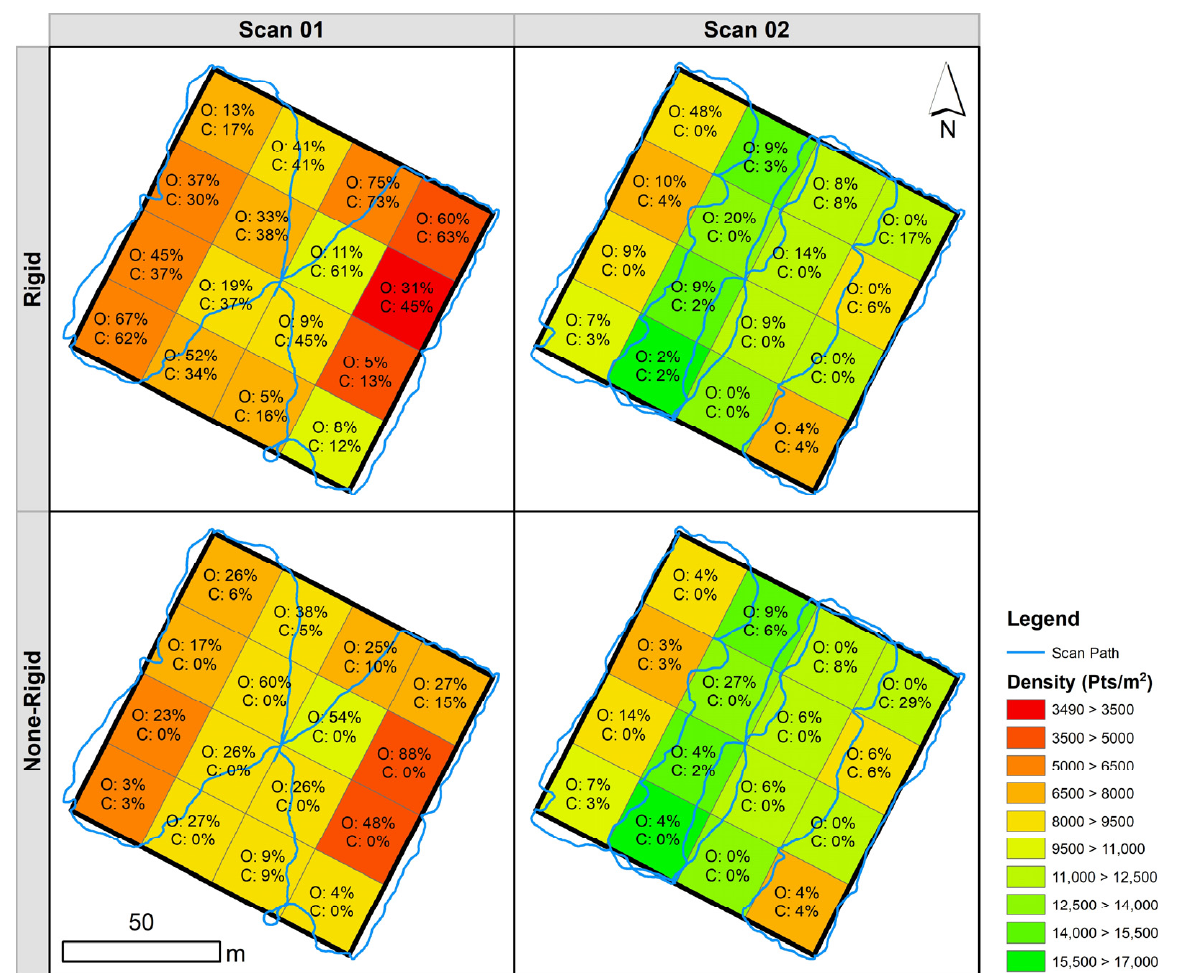
Figure A1. Representation of scanning density (coloured background) and commission and omis- sion errors in the study. The latter two are shown as percentages for each section of the forests (O: omission: C: commission).